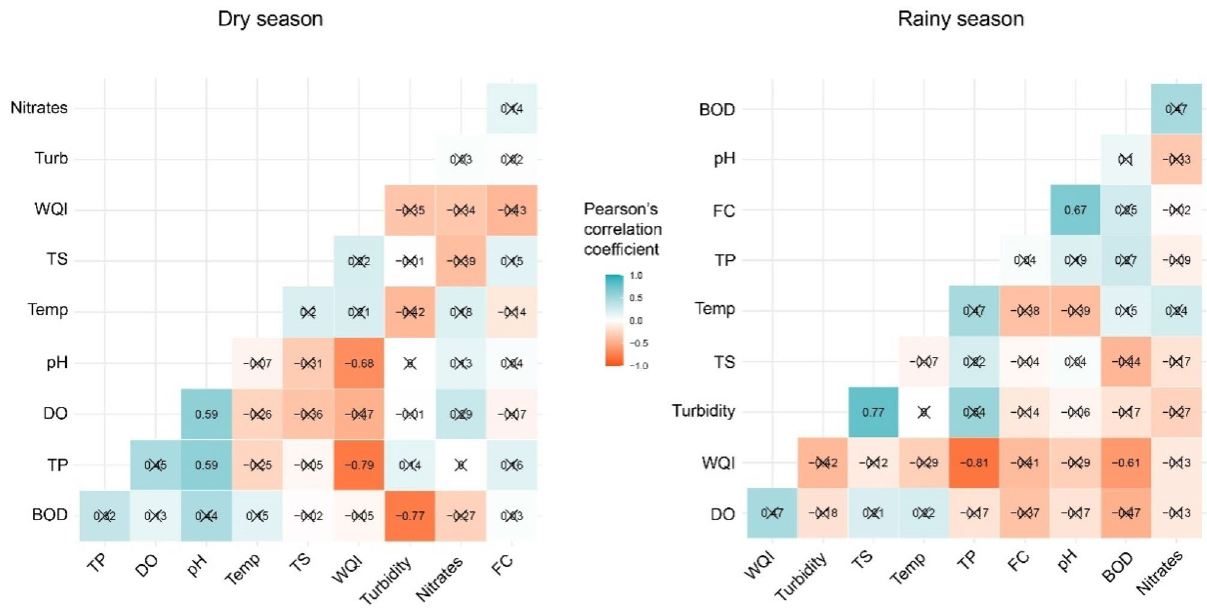
Figure 4. The correlation plot between water quality parameters and the NSFWQI in the seasons. Source: authors’ self-implementation with R software version 4.0.0 (https:// www.r- proje ct. org/).